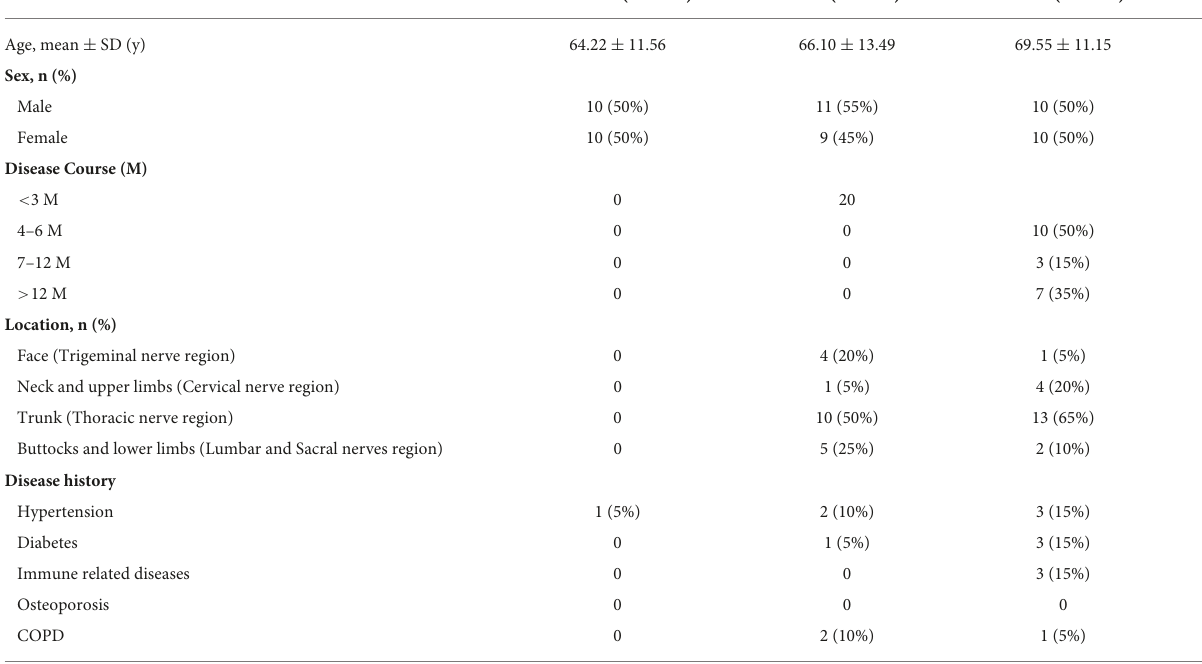
TABLE 1 Characteristics of the study